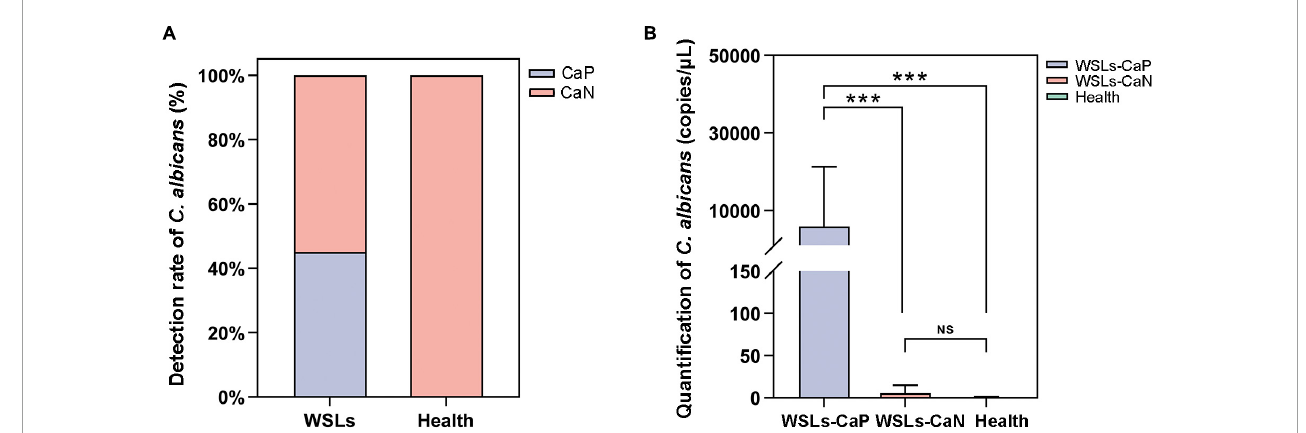
FIGURE3 Candida albicans infection in the supragingival plaque. (A) The positive rate of C. albicans in WSLs and health groups. Positive result of C. albicans infection was determined by inoculation once the colonies emerged on CHROMAgar. Among all WSLs patients, 45% were C. albicans positive, but none in the health group. CaP: C. albicans positive; CaN: C. albicans negative. (B) Quantification of C. albicans in supragingival plaque among WSLs-CaP, WSLs-CaN, and health groups. C. albicans (copies/uL) in WSL-CaP group was remarkably higher than WSL-CaN and health groups (NS: no significance, *** P < 0.001).